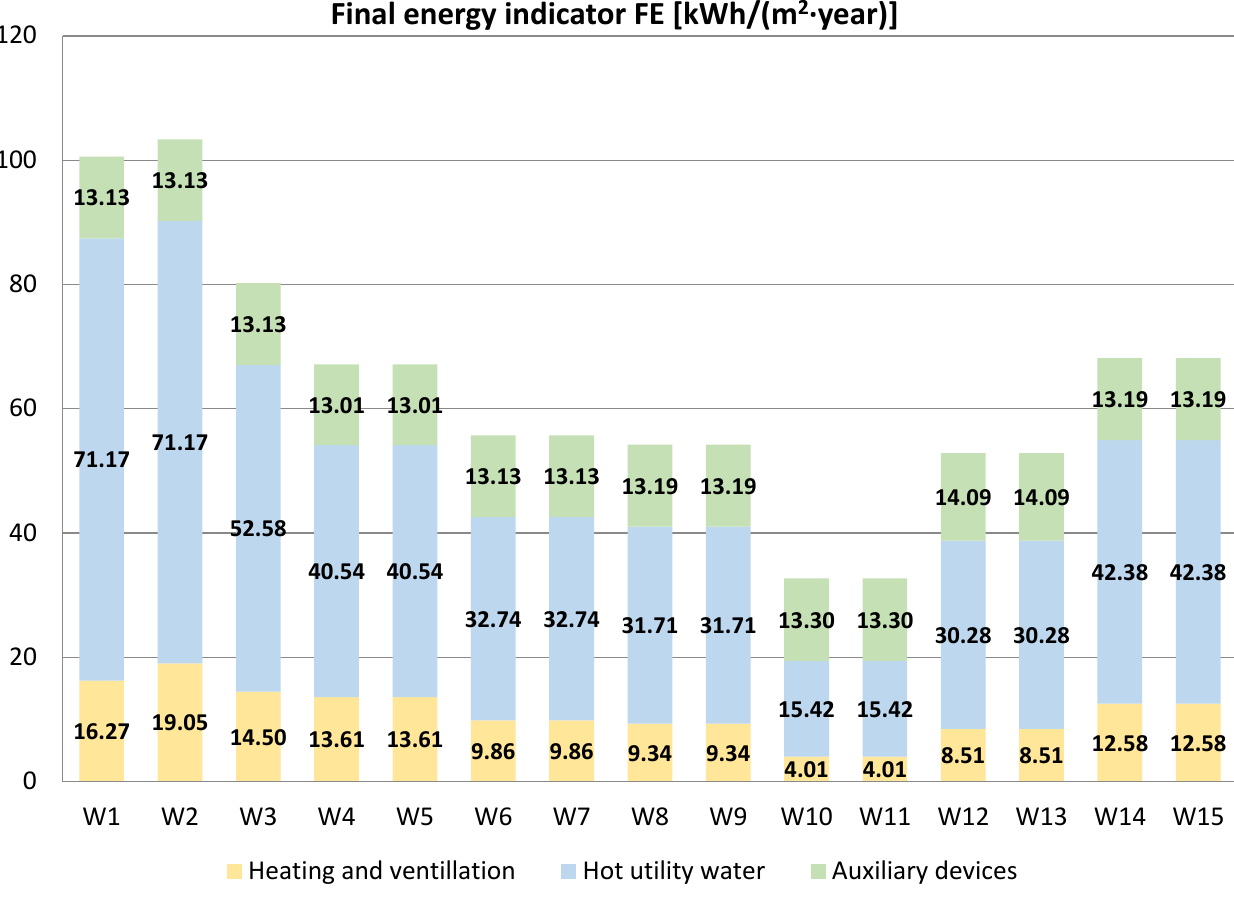
Scheme 8. Comparison of indicators of demand for final energy of FE for various heat sources and energy carriers.